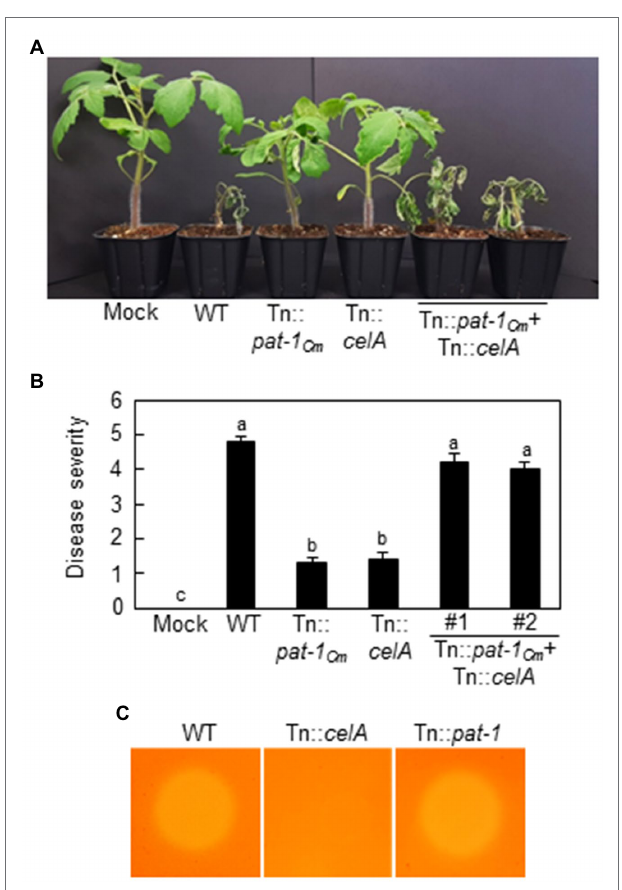
FIGURE 8 | Functional cooperation of Pat-1 Cm with another major pathogenicity factor, CelA (cellulase), during Clavibacter michiganensis infection of tomato plants. (A) Wilting symptom development in tomato plants inoculated with individual or mixed strains. Two-week-old plants were inoculated, and disease symptoms were photographed 14 dai. (B) Disease severity of wilting in tomato plants inoculated with mixed strains at 14 dai. Error bars indicate SE ( n = 10). Nonparametric Kruskal–Wallis test with Dunnett’s multiple comparisons ( p < 0.05) was used to analyze the level of disease severity in tomato plants, and different letters indicate statistically significant differences at p < 0.05. (C) Plate assay for detection of cellulase activity in Tn:: celA and Tn:: pat-1 Cm mutant strains using carboxymethyl cellulose (CMC) agar plates strained with Congo Red. Mock, 10 mM MgCl 2 ; WT, C. michiganensis LMG7333 wild